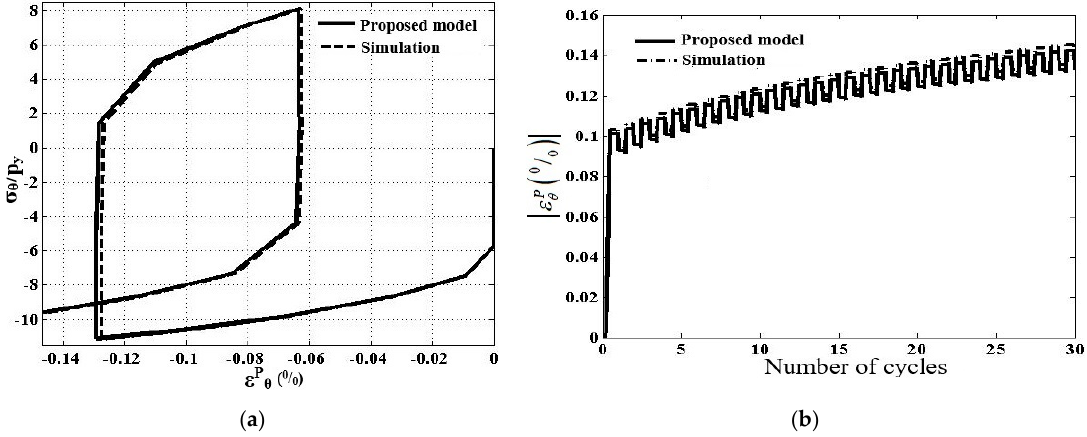
Figure 10. Comparison between proposed numerical model and finite element (FE) simulation with m i ( i = 1 : 5 ) = 0. ( a ) Hysteresis stress–plastic strain curve in hoop direction, p in = 0.65 p y and T in = 3.6 T y . ( b ) Evolution of absolute values of circumferential plastic strain as a function of the number of cycles, p in = 0.25 p y and T in = 2.5 T y .